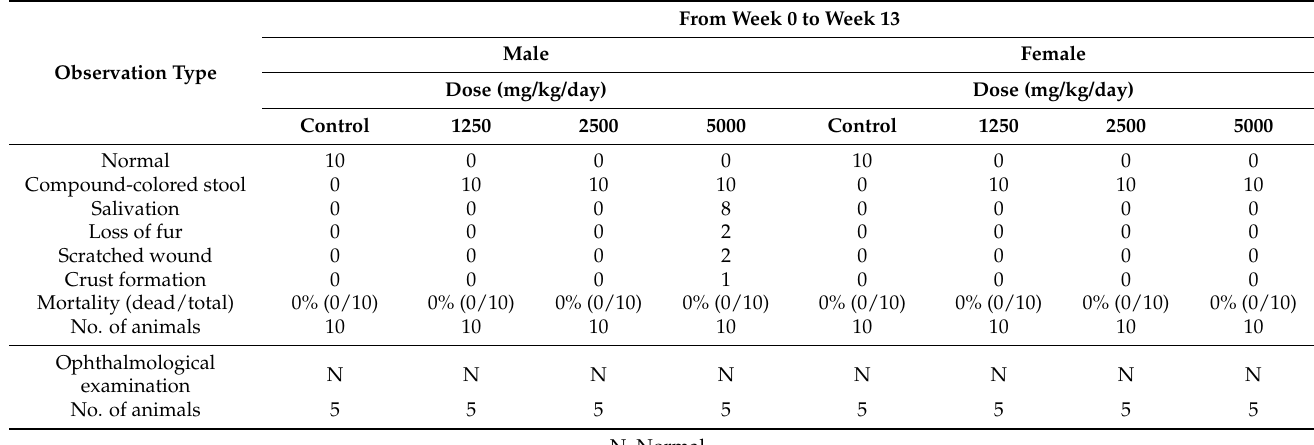
Table 4. Mortality, clinical signs, and ophthalmological examination in 13 weeks repeated oral dose toxicity of WG extract.